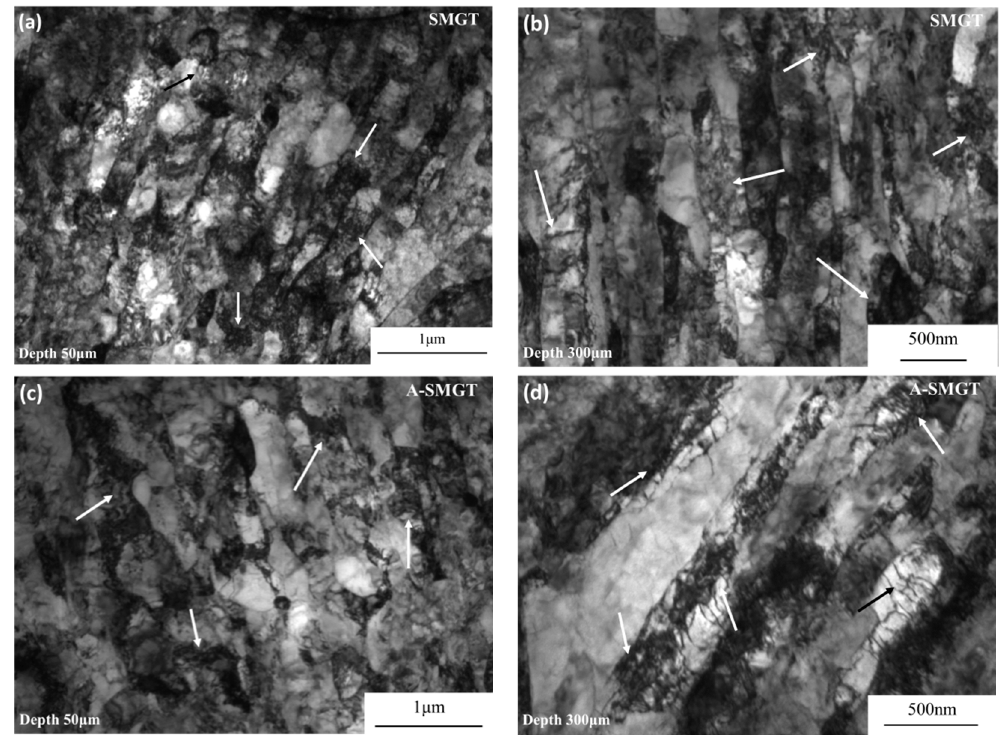
Figure 9. Dislocation structure of different depths from the surface of SMGTed Zr-4 samples and A-SMGTed Zr-4 samples after uniaxial tension–compression fatigue, SMGTed: ( a ) 50 μ m and ( b ) 300 μ m, and A-SMGTed: ( c ) 50 μ m and ( d ) 300 μ m. The arrows indicate the dislocation tangles in the gradient nanostructured surface layer.